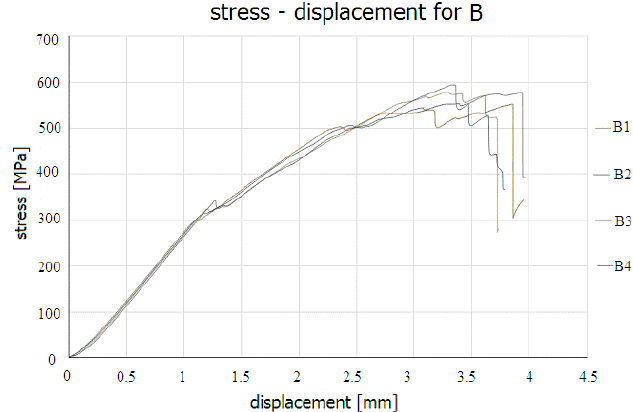
Figure 5. Mechanical characteristics of the 3-point bending test for reference samples–group A.